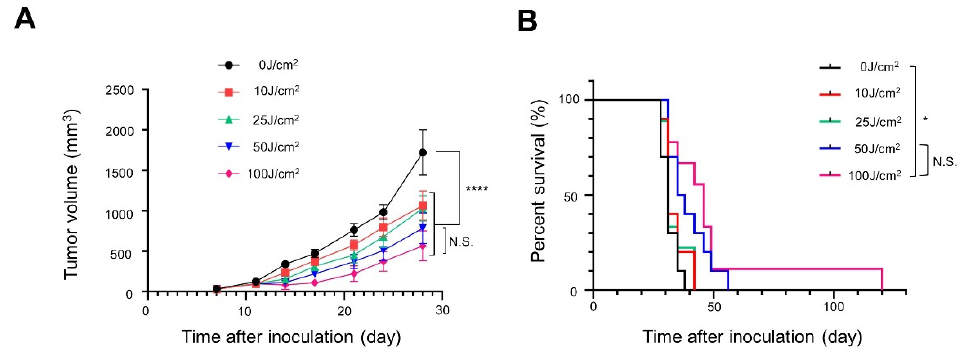
Figure 3. In vivo long-term efficacy of NIR-PIT with Pan-IR700 in A431-GFP-luc cells: ( A ) tumor volume curve ( n = 10; one-way ANOVA followed by Tukey’s test; ****, p < 0.0001; 0 J/cm 2 group vs. the other groups; N.S.: not significant; 50 J/cm 2 vs. 100 J/cm 2 ); ( B ) Kaplan–Meier survival curve ( n = 10; log-rank test with Bonferroni correction; *, p < 0.05; N.S.: not significant).